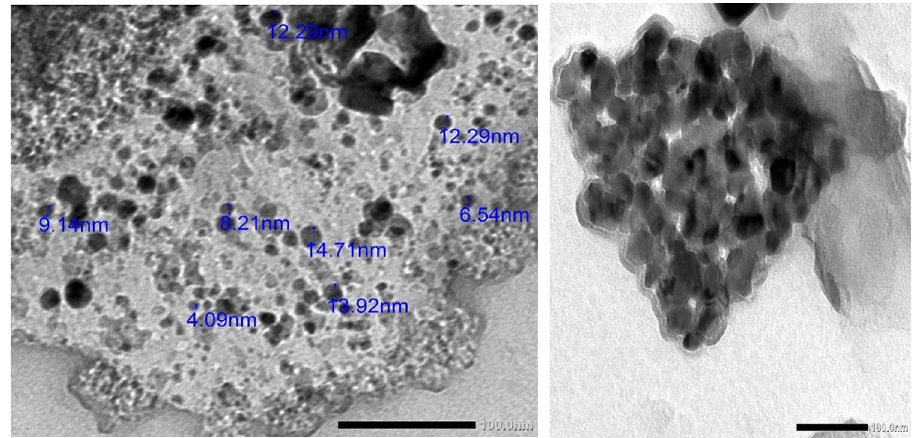
Figure 7. TEM images of the PDMS-SiO 2 nano coating.